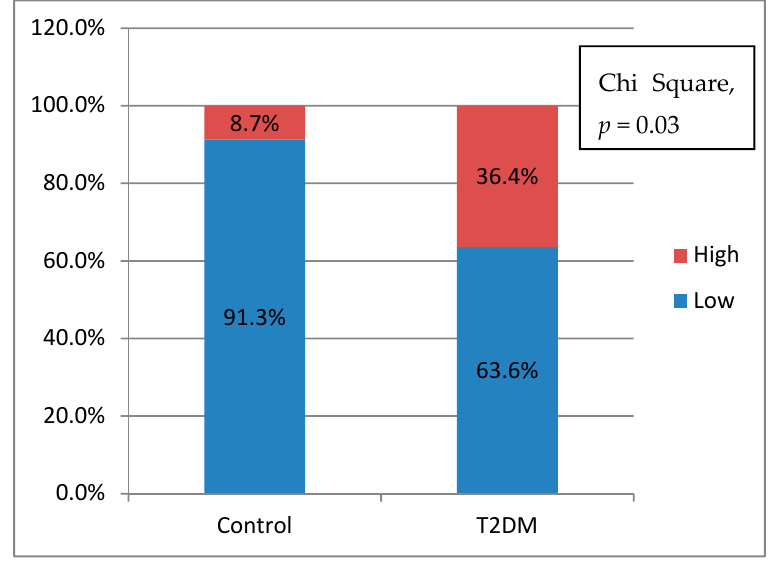
Figure 1. Pro-inflammatory potential differences.